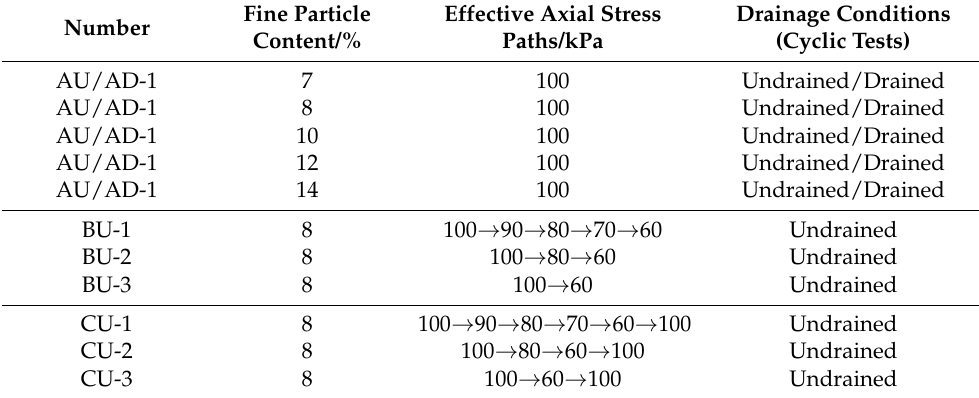
Table 3. Test scheme.